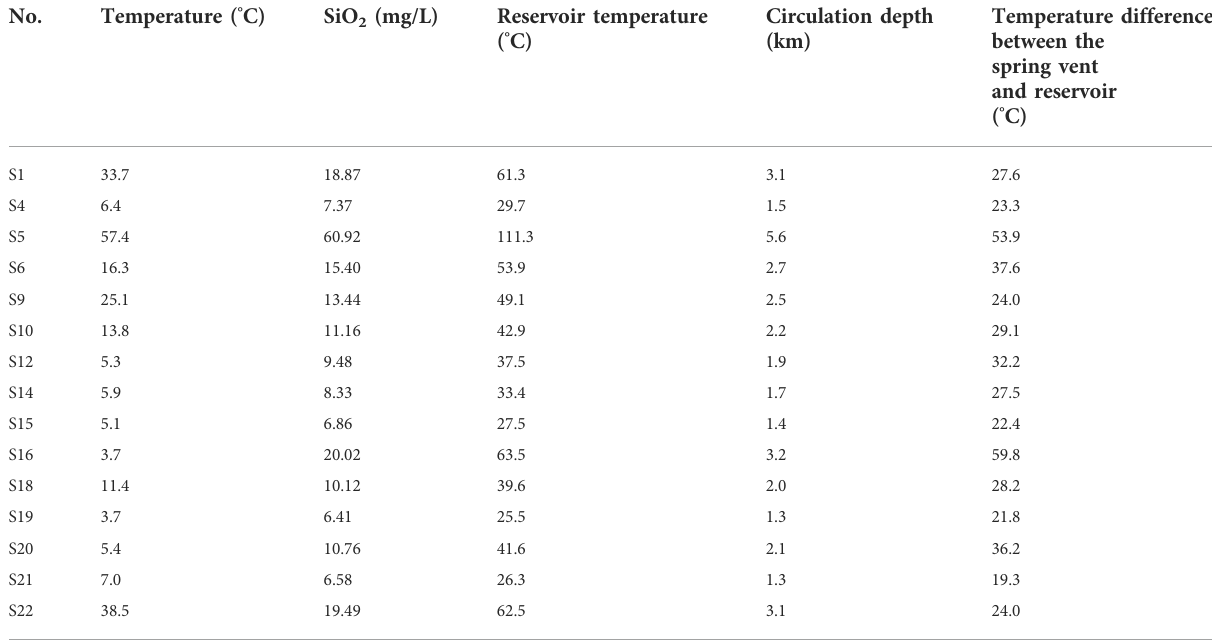
TABLE 2 Calculation of reservoir temperature and circulation